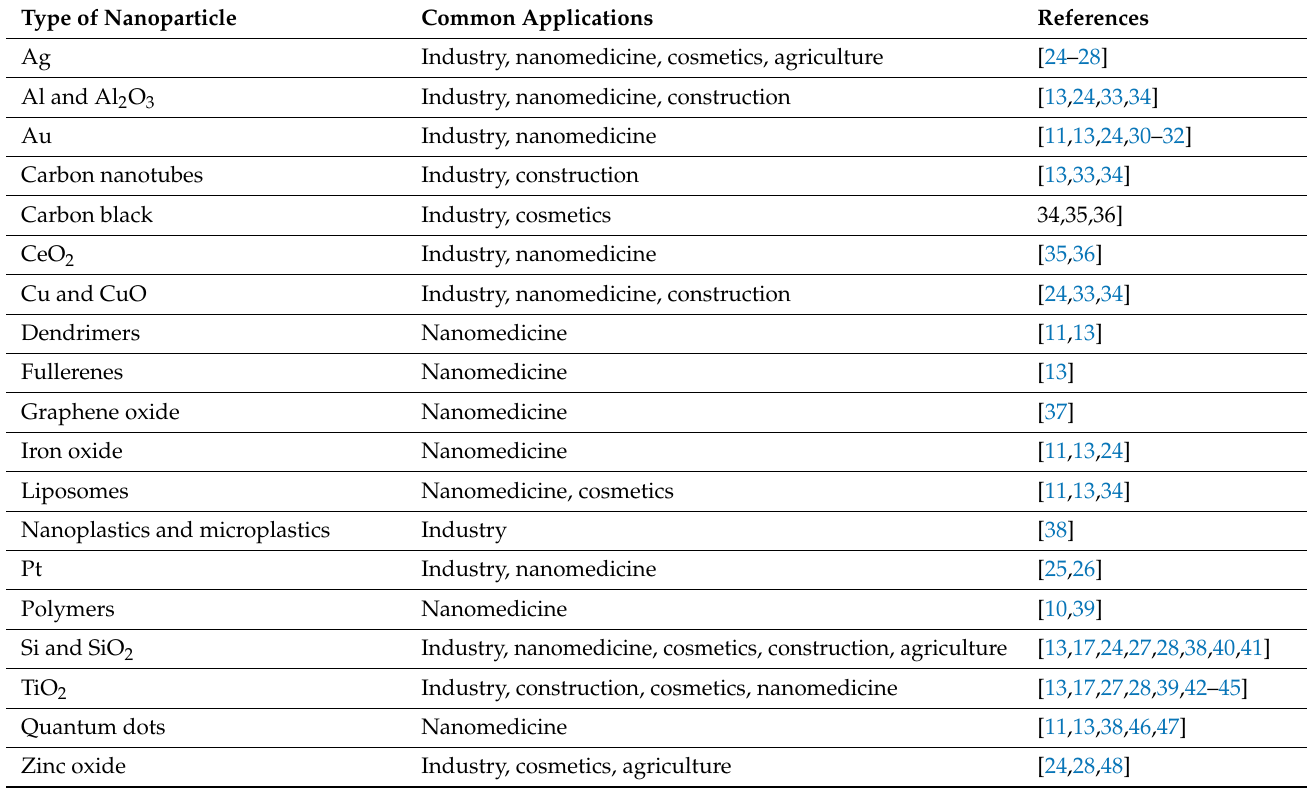
Table 1. Applications for nanoparticles used in the studies in this